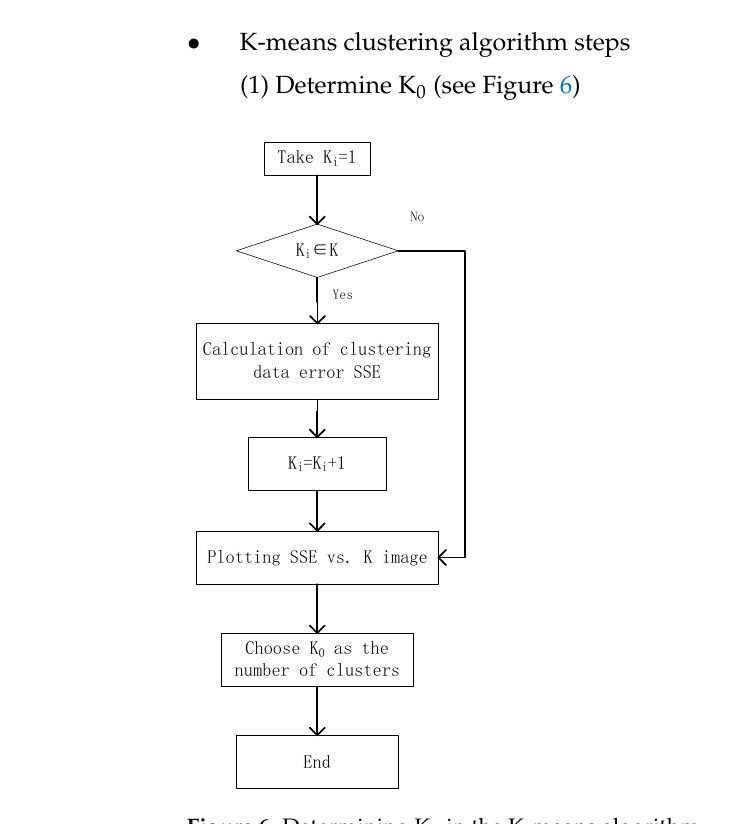
Figure 6. Determining K 0 in the K-means algorithm.